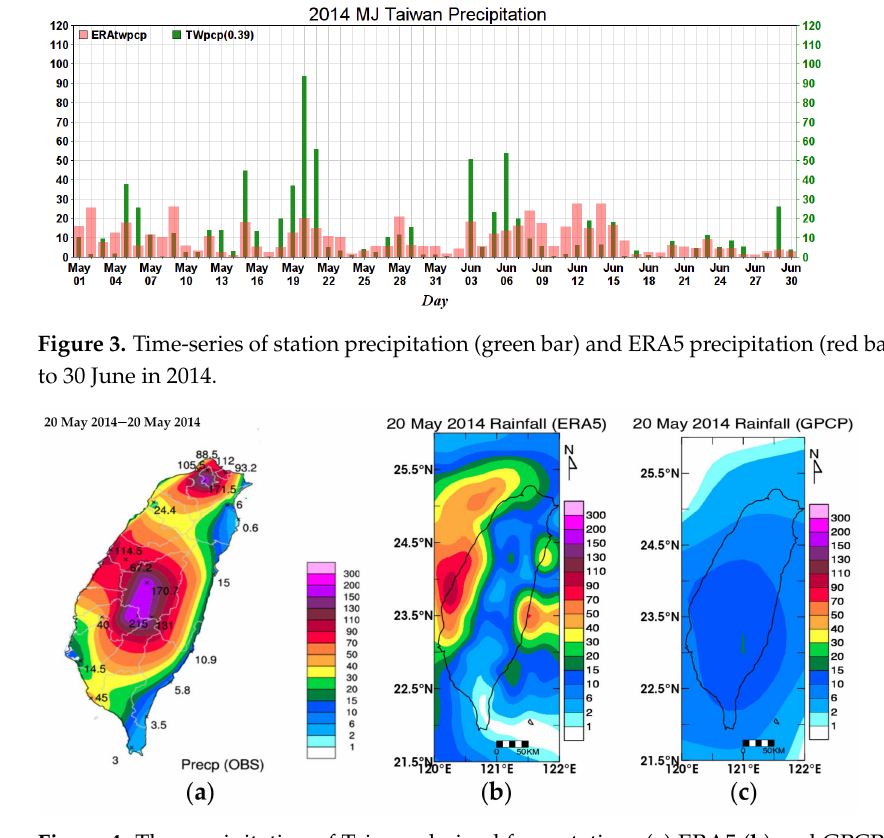
Figure 4. The precipitation of Taiwan derived from stations ( a ) ERA5 ( b ) and GPCP ( c ) at 20 May in